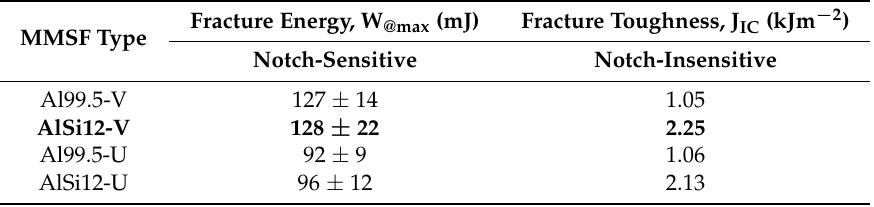
Table 2. Results of the toughness measurements.